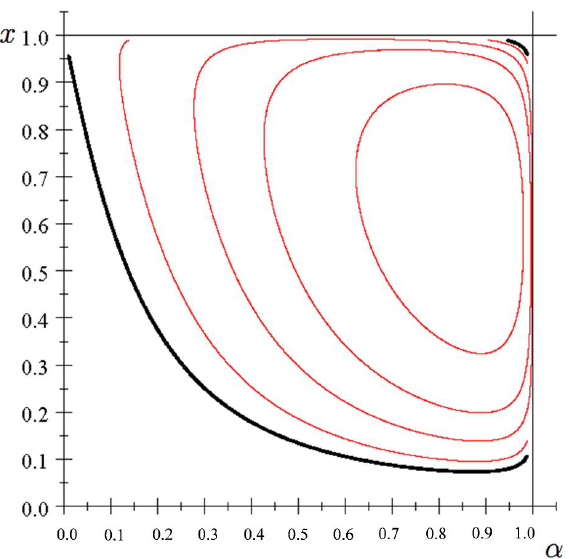
Figure 6. Contour map for the maximand in